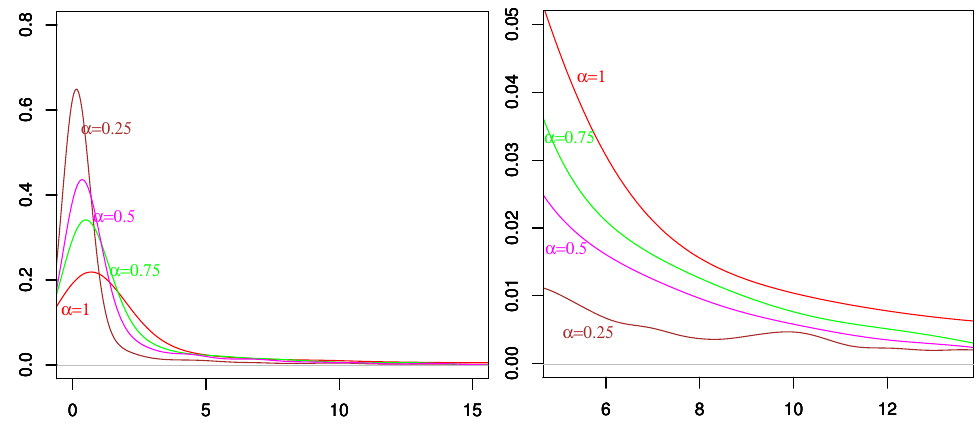
Figure 1. Left : Comparisons of FPT densities of X α ( t ) through the boundary S = 0.1 for several values of α . The samples are until 5000 simulation paths and the time discretization step is 0.05. Right : Zoom on tails of densities (shown on the left) for several values of α